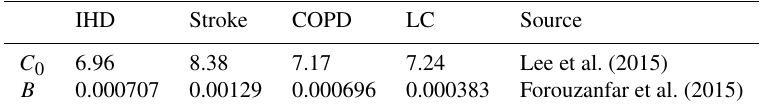
Table A2. Counterfactual concentrations and death incidences used in the IER